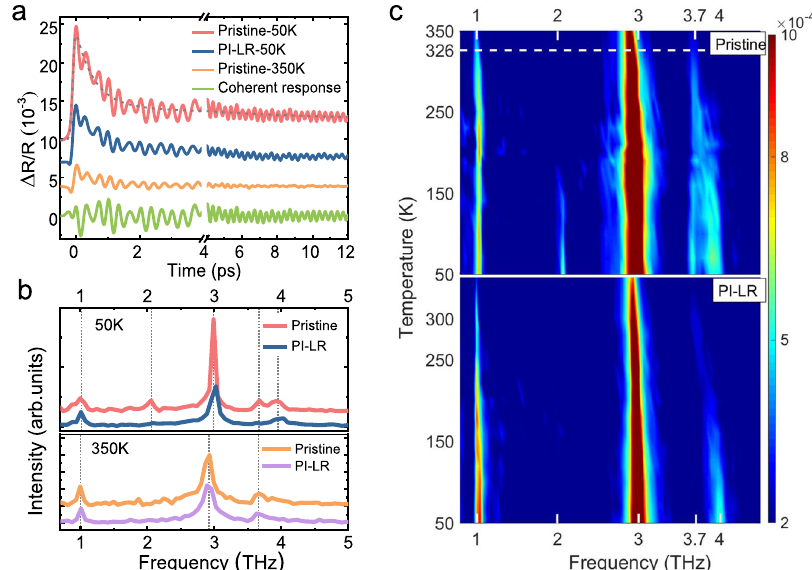
Fig. 2 Pump – probe response spectra. a Transient photoinduced re fl ectivity at various states. The signal is made up of the electronic response and the coherent oscillations. The gray lines represent fi ts to the measured data. b The corresponding FFTs from transient re fl ectivity spectra after substracting the incoherent components. c The temperature evolution of the coherent phonon spectra of pristine state (upper panel) and the PI-LR state (lower panel). In the experiment, the light polarizations of pump and probe are set parallel and perpendicular to a-axis